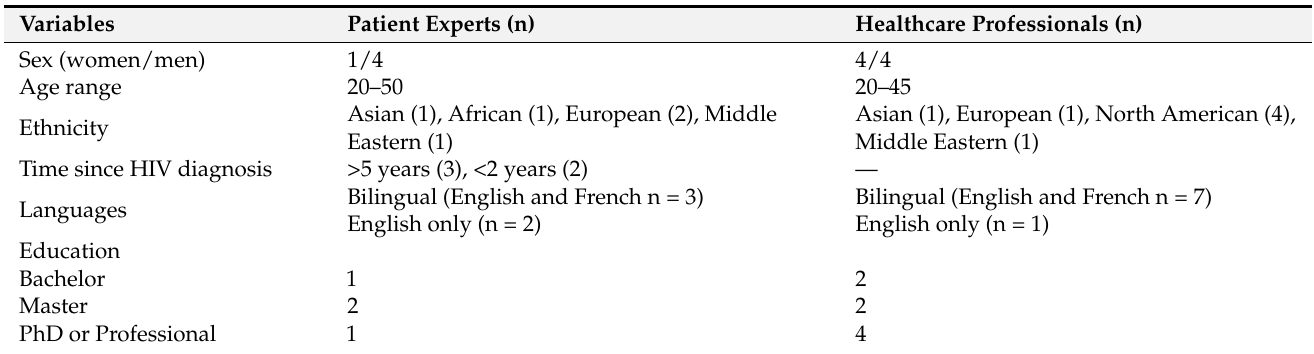
Table 7. Characteristics of the patient experts and healthcare professionals who participated in the cognitive interviews.